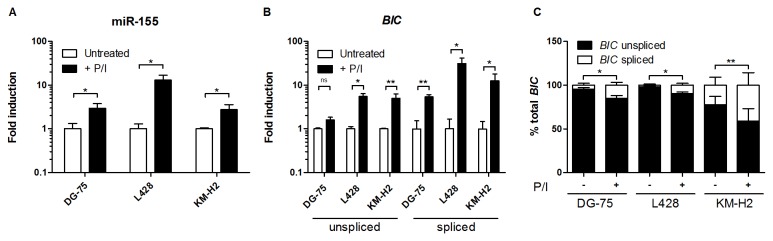
Induction of unspliced and spliced BIC transcripts upon cellular activation.Fold induction in miR-155 (A), unspliced BIC and spliced BIC transcript (B) levels upon PMA/Ionomycin (P/I) treatment. Levels of miR-155 and BIC transcripts in untreated cells were averaged and fold induction upon P/I treatment was calculated. In all three cell lines, induction of spliced BIC was higher than of unspliced BIC transcripts. (C) Unspliced BIC transcripts were predominant in both untreated and P/I-treated cells, however unspliced/spliced BIC ratio significantly decreased upon P/I treatment. Sum of spliced and unspliced BIC transcript levels was set as 100%. Average of three (DG-75 and L428) or four (KM-H2) experiments was presented. P values were determined by a Student’s t-test (* p<0.05, ** p<0.01, ns - not significant).